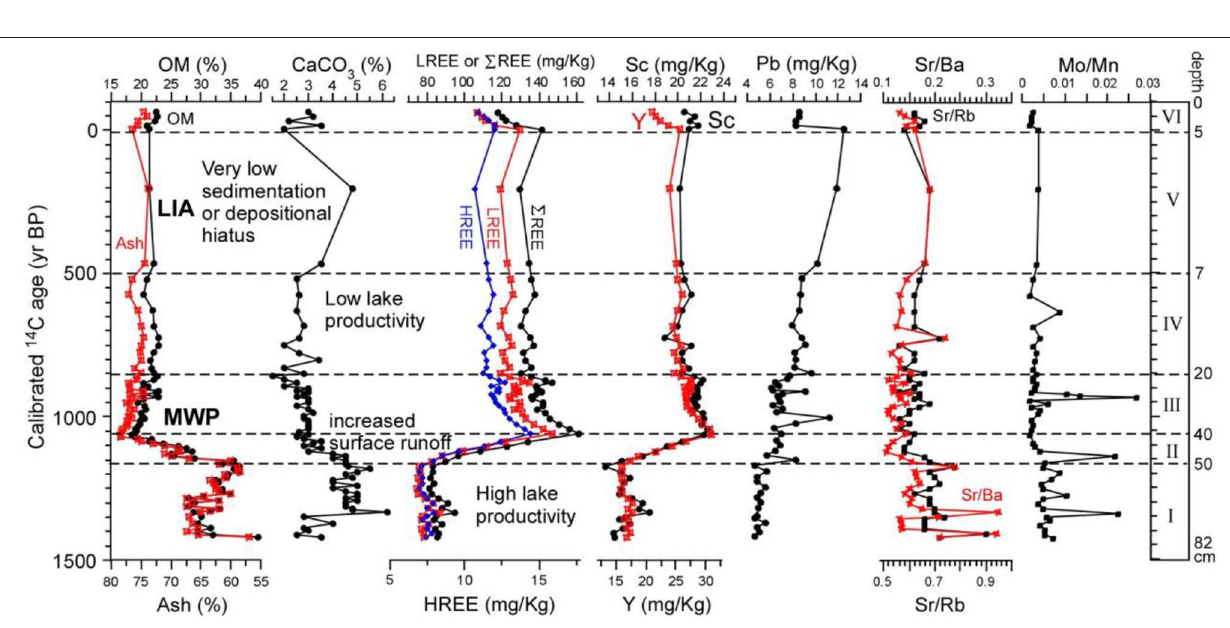
FIGURE 8 | Classification of the geochemical zones in the Manzherok Lake sediment